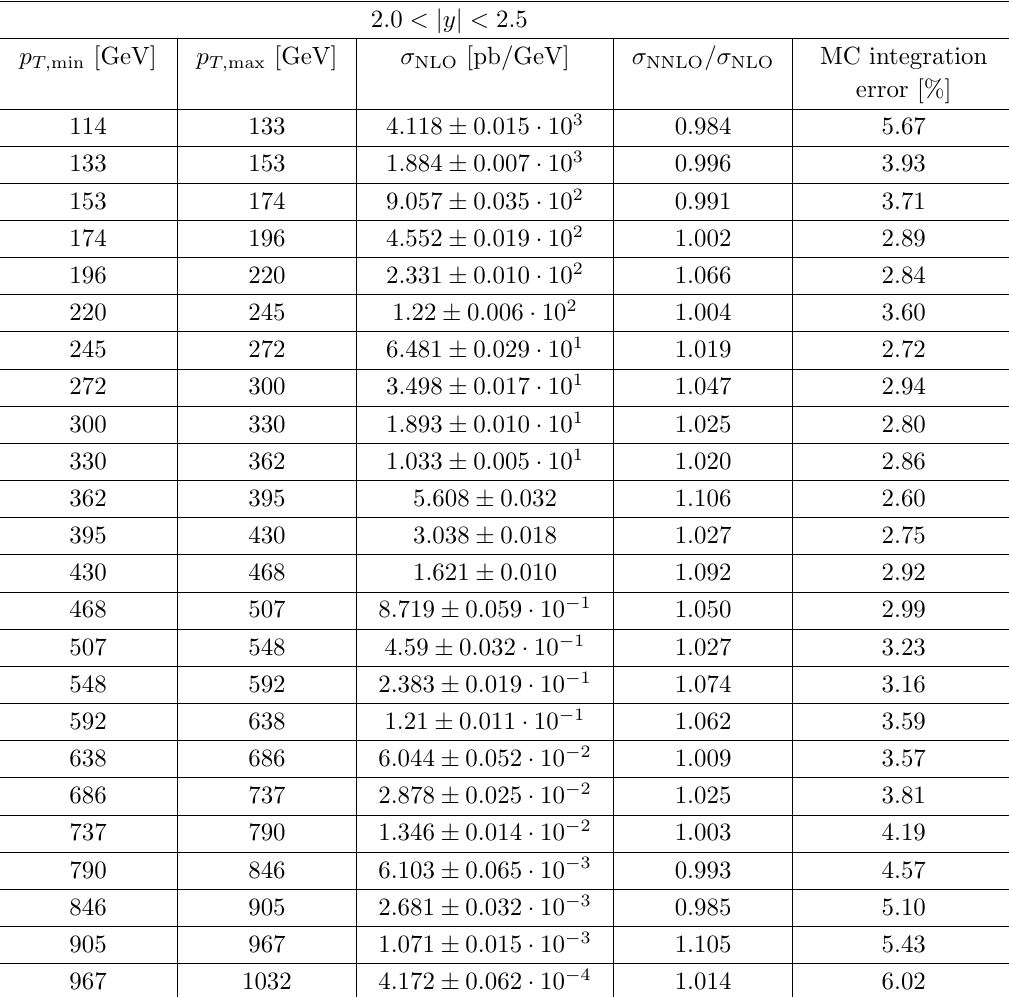
Table 5 . NLO QCD single-inclusive cross section and NNLO QCD K-factors in the rapidity slice y < 2 : 2 : 0 < j j